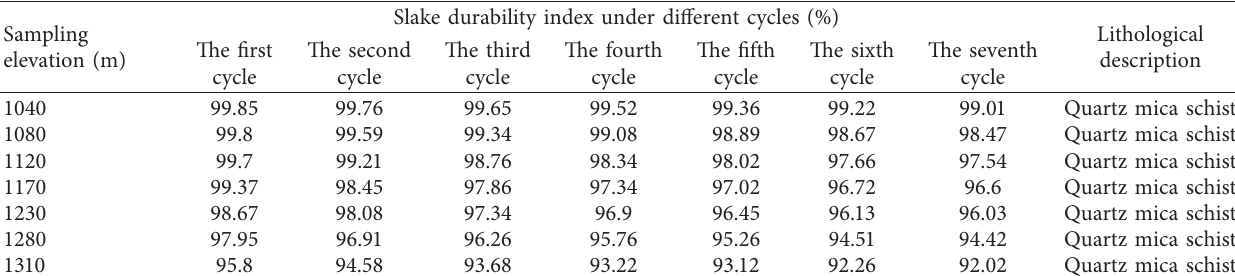
Table 1: Test results of rock collapse resistance at different